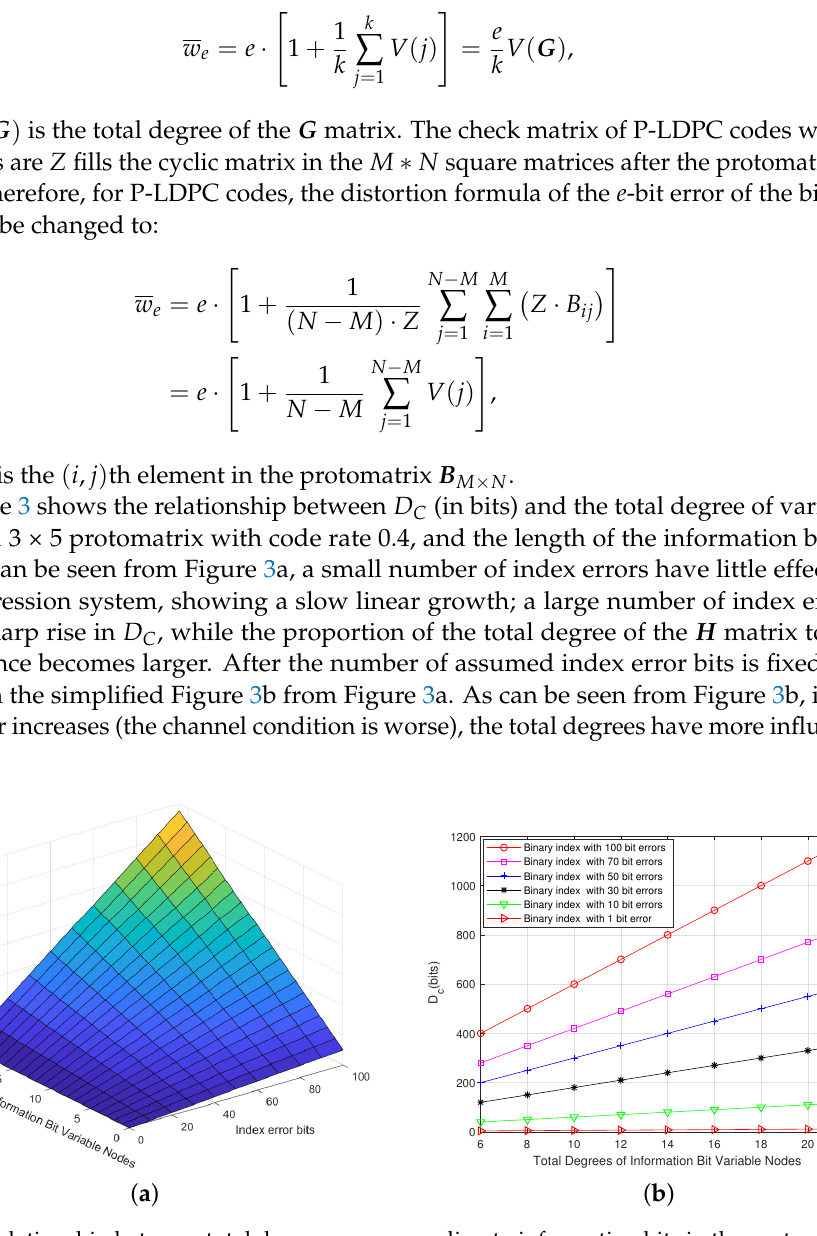
Figure 3. Relationship between total degrees corresponding to information bits in the protomatrix and D C . ( a ) Effects of different transmission errors and total degrees on D C ( b ) Distortion effects of increased total degrees for different index